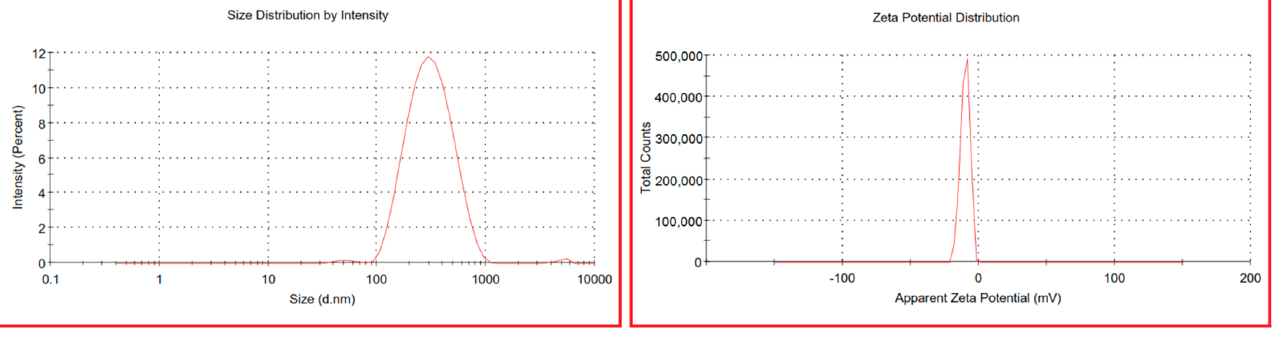
Figure 3. Particle size and zeta potential of optimum ALN formulation. Table 2. Release Kinetics of optimum ALN